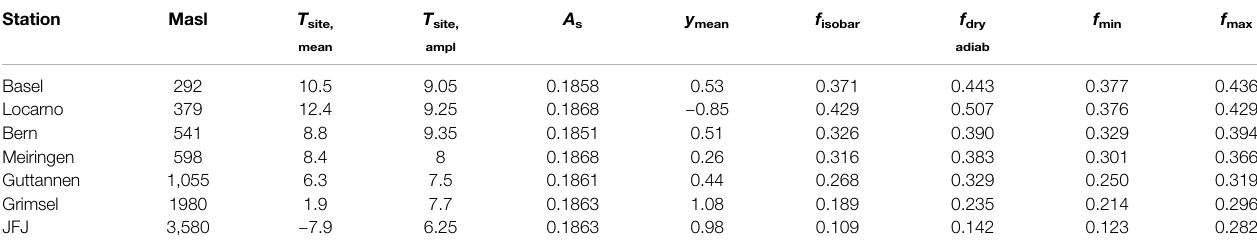
TABLE2| ComparisonofRayleighparameterfbasedonmeteodata( f isobar , f dryadiabatic )vs.isotopedata(puresourcein fl uenced, y (cid:1) 1 → f min orpuresitein fl uenced, y (cid:1) 0 → f max ), y mean is related to f mean (mean of f isobar and f dry adiab ), A s is calculated based on Eq. 23 from A r (cid:1) 0.187,664,259 and λ s from Table 1 . For the dry adiabatic calculations we used a value κ (cid:1) c p /c v of 1.4 for heat capacity of water at constant pressure (c p ) and constant volume (c v ).